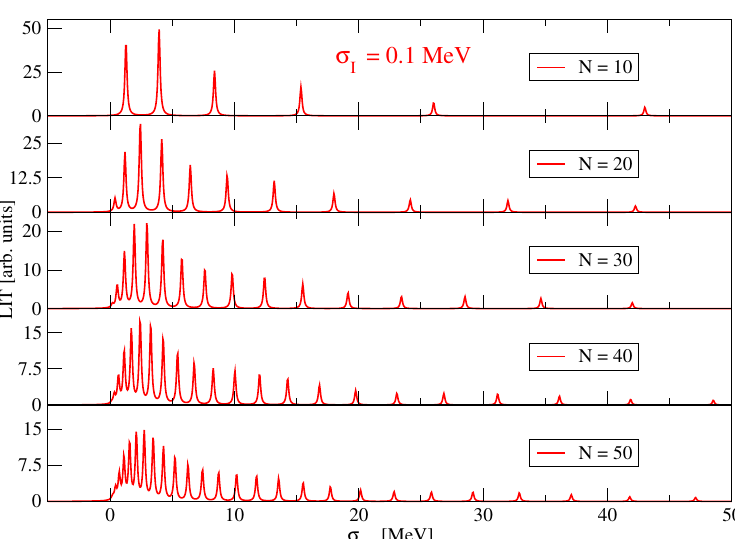
Figure 2. Deuteron photodisintegration in unretarded dipole approximation: LIT result for partial wave 3 P 1